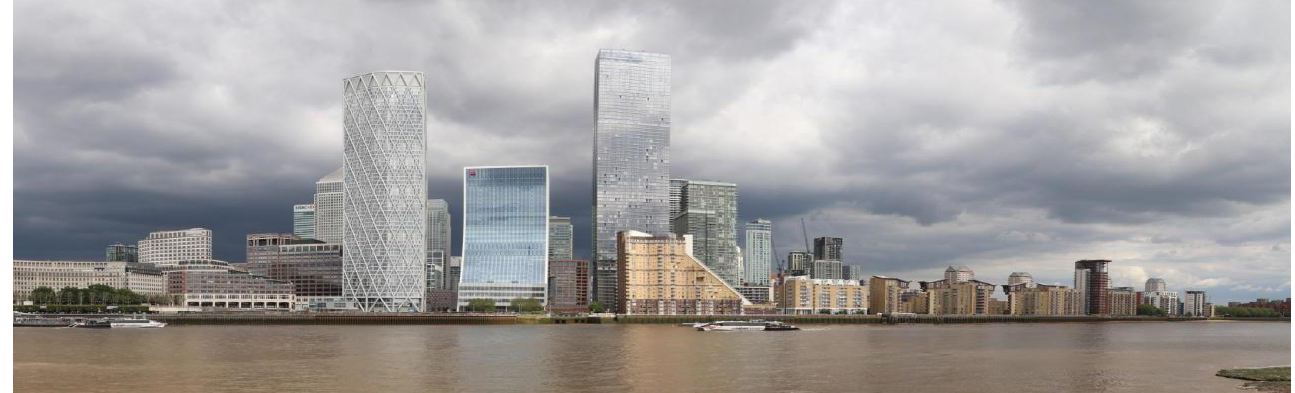
Figure 7. Panorama of the tall buildings clusters around Canary Wharf, view from West (2021). Tall buildings in the foreground, from the left: Newfoundland, 1 Bank Street, Landmark Pinnacle, Cas- cades. In the background from the left: 8 Canada Square, One Canada Square, 25 Canada Square, 1 Churchill Place, Landmark, Novotel, Maine